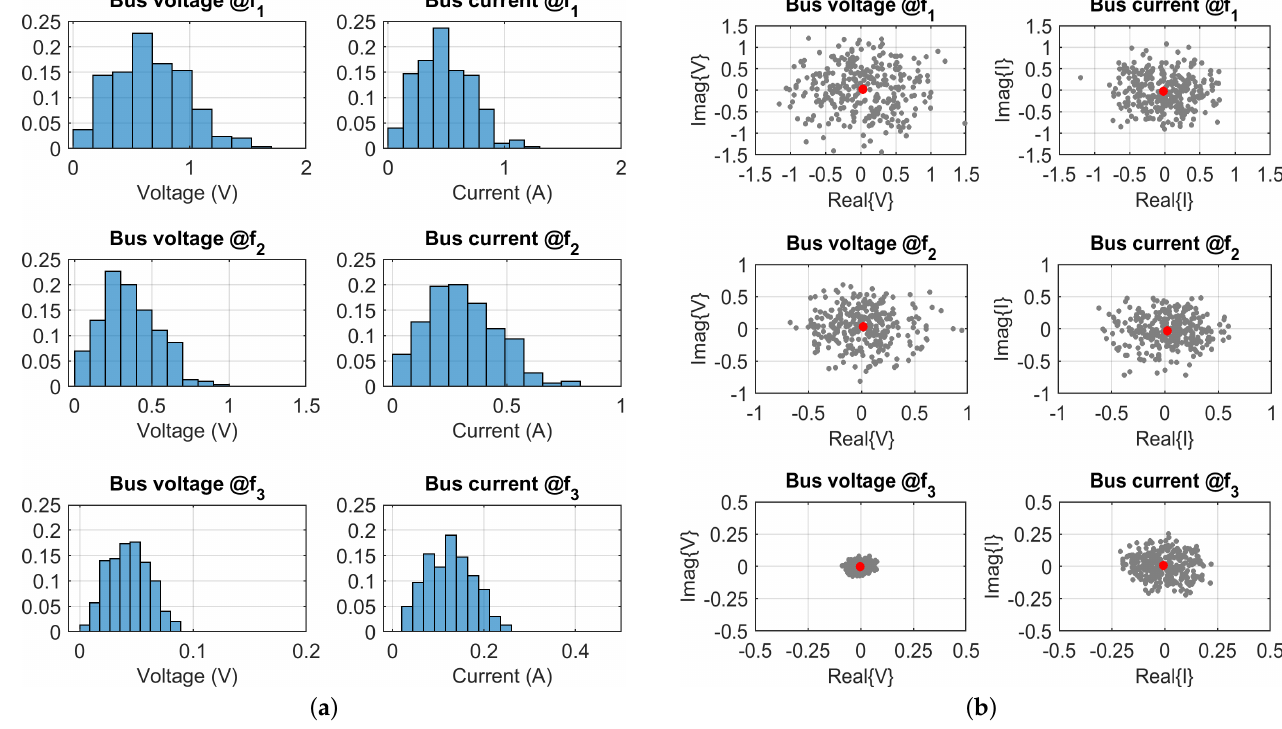
Figure 14. ( a , b ) Results of MCM simulations for the ten-converter network obtained by augmenting the converters at the farthest position (converter cluster at position 3 separated by 5m of line cable